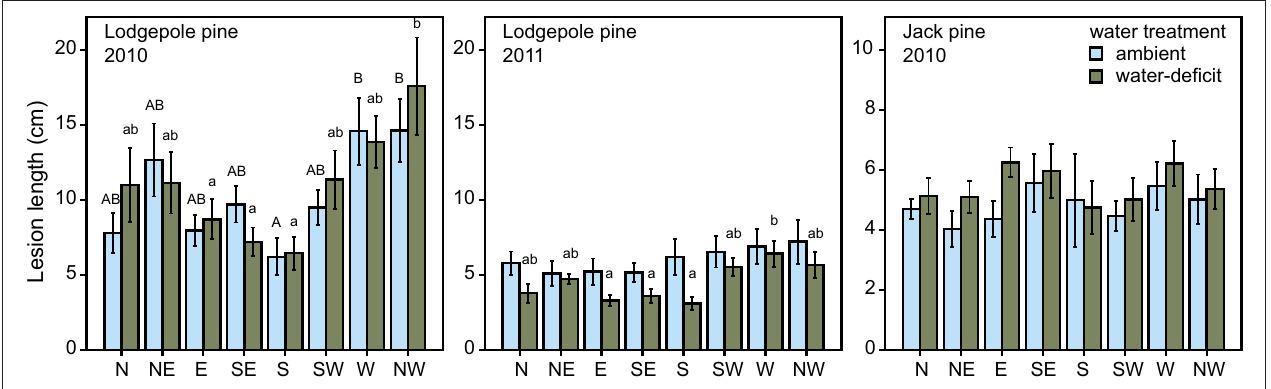
FIGURE 6 | Lesion length (mean ± S.E.) in lodgepole pine ( P. contorta ) after tree harvest in 2010 and 2011 and in jack pine ( P. banksiana ) in 2010. Cardinal point of the fungal inoculum significantly influenced lesion length in lodgepole pine. Bars marked with different uppercase letters indicate a statistically significant difference in ambient trees, whereas bars marked with different lowercase letters indicate a statistically significant difference in water-deficit trees (ANOVA, P < 0.05 ).